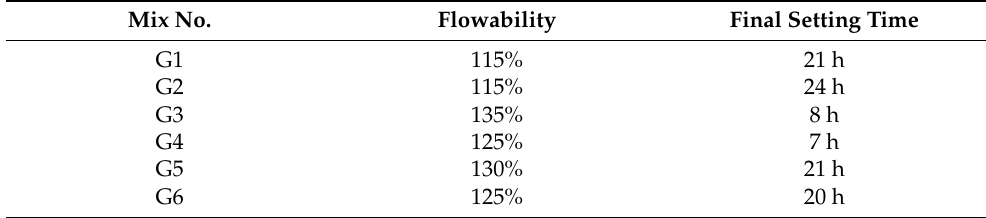
Table 3. Results of flowability and setting time.